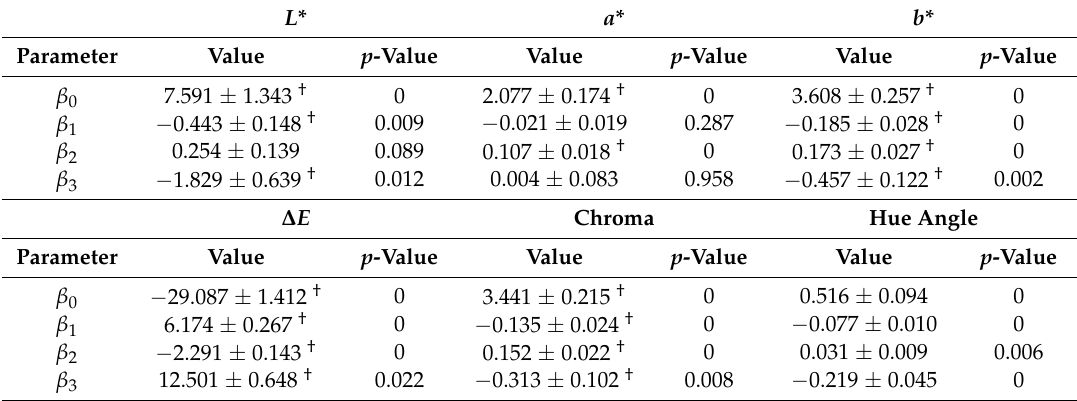
Table 9. Linear regression models coefficients for description of colour components change